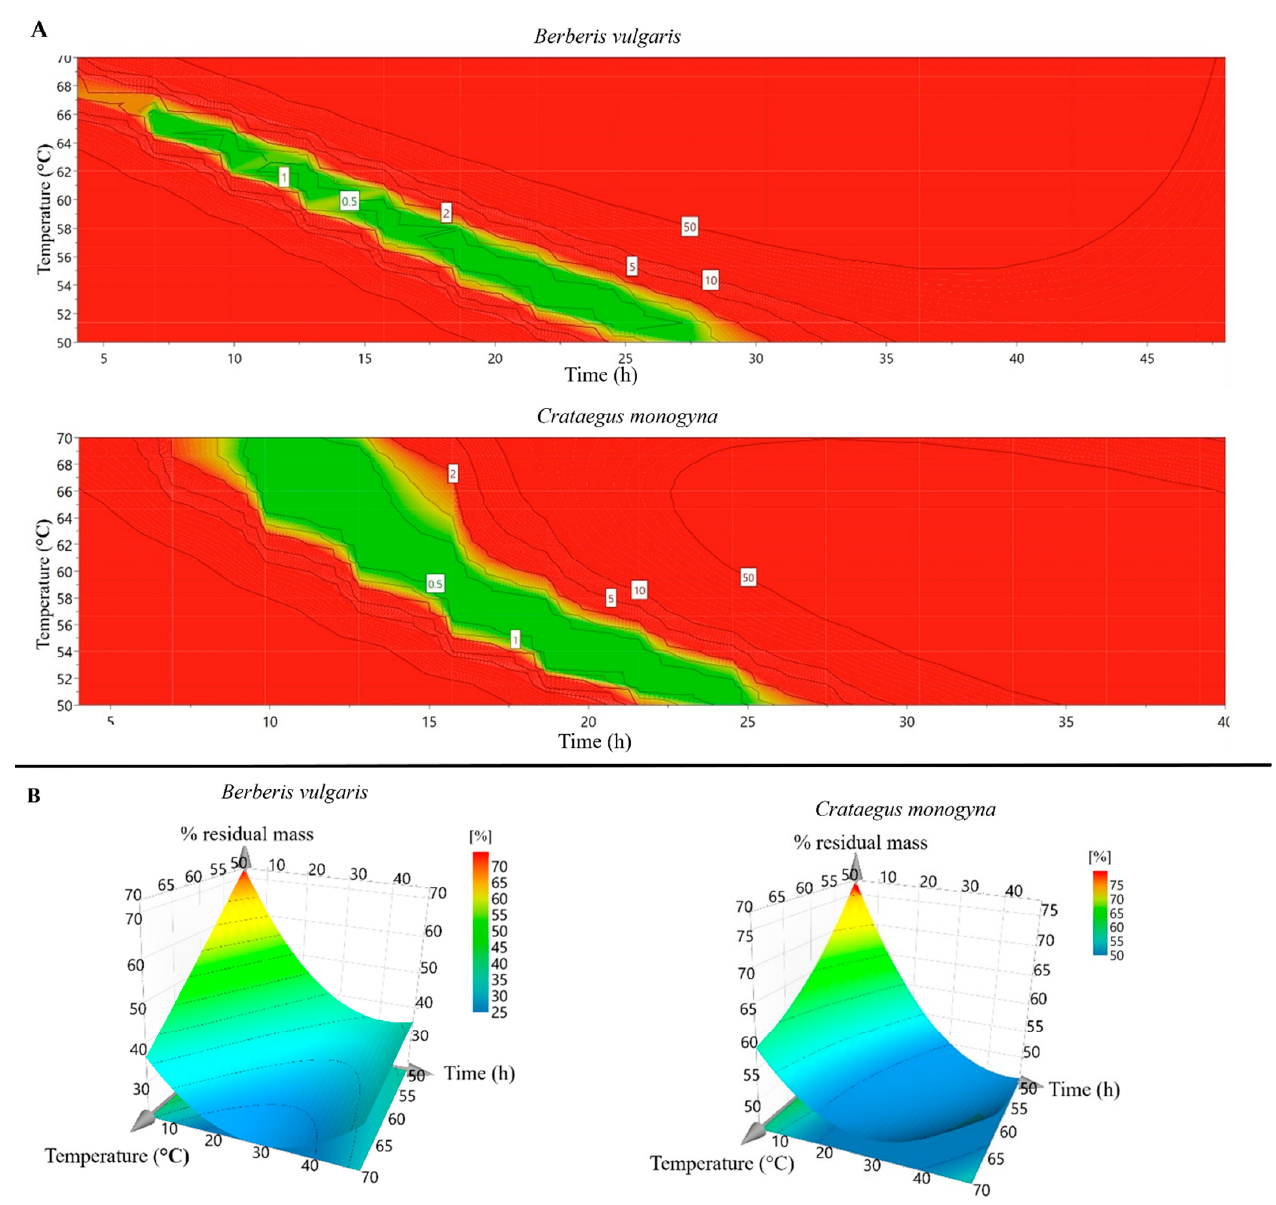
Figure 2. ( A ) Optimal temperature conditions represented in design spaces as a function of time for drying processes, ( B ) 3D-response surface plots: The interdependence between critical drying process parameters (temperature and time of drying) with the percent of residual mass for B. vulgaris and C. monogyna samples.